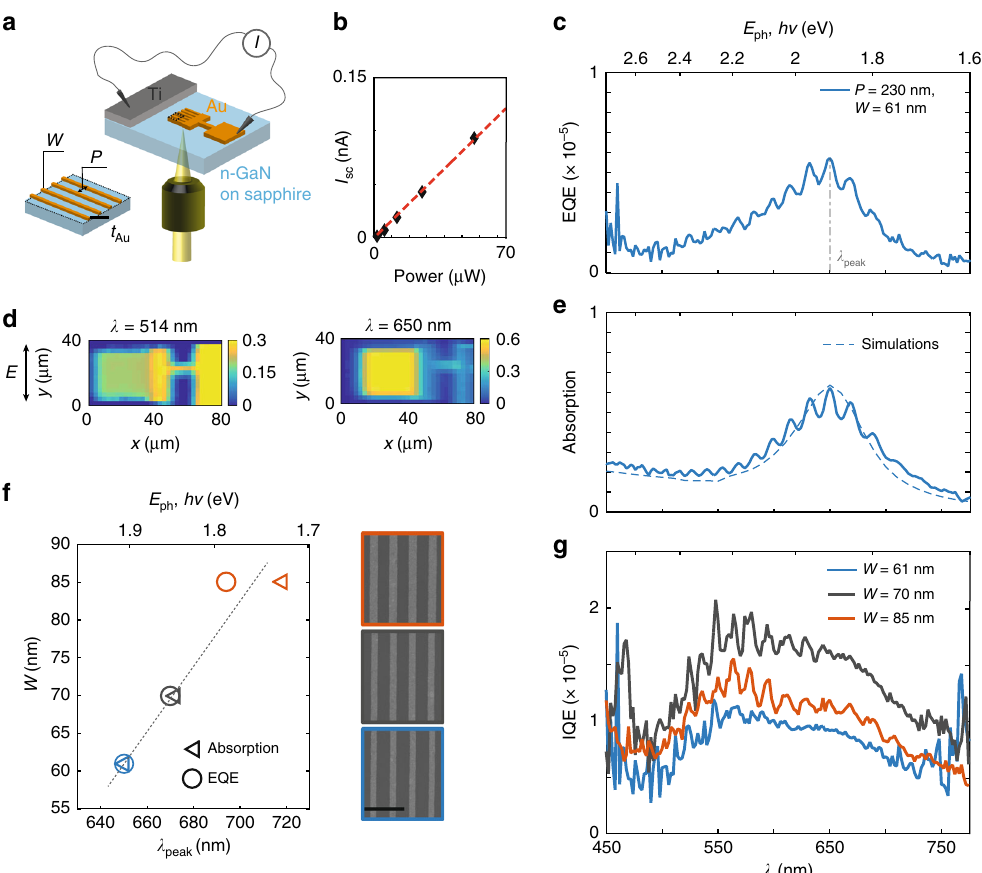
Fig. 2 Role of plasmon excitation on hot electron IPE in metal – semiconductor heterostructures. a Schematic representation of the designed plasmonic heterostructures as well as measurement con fi guration: a 20 nm thick, nano-patterned gold (Au) photoelectrode is fabricated on n-type GaN (3.4 eV band gap, Schottky barrier Φ B ~1.2 eV) together with a 75 nm thick titanium (Ti) Ohmic contact; light is incident on the plasmonic resonant Au nanostripe array (stripe width W , array period P from the bottom and the photocurrent is collected via two microcontact probes); b short-circuit photocurrent I sc (i.e., 0 V applied bias) upon illumination of one heterostructure ( W = 61 nm) with a diode laser ( λ laser = 633 nm) as a function of incident power; c EQE spectrum of the fabricated heterostructure with stripe width W = 61 nm and periodicity P = 230 nm exhibiting a resonance peak at λ peak = 650 nm; d spatial maps of absorption for illumination of the Au photoelectrode off-resonance (514 nm – 2.14 eV) and on-resonance (650 nm – 1.9 eV) with light polarized perpendicular to the stripes; e measured (solid line) and simulated (dashed line) absorption spectra for the same heterostructure exhibiting a plasmon resonance at λ peak = 650 nm; f EQE and absorption resonance peak wavelengths ( λ P = 230 nm) and peak ) for three heterostructures with constant array periodicity ( increasing nanostripe width, W , equal to 61 nm (blue), 70 nm (gray), and 85 nm (red), respectively. Representative SEM micrographs are shown on the right (scale bar = 500 nm); g IQE spectra of the three plasmonic heterostructures shown in part ( f rate is dependent on both incident photon energy and the elec- tronic band structure of the metal 32,35 . For photon energies below the interband threshold of Au ( h ν IB ~1.8 eV), hot electrons gen- erated via intraband transitions have a nearly uniform probability at all energies from the Fermi level up to the photon energy (Fig. 3a, solid red curve). As a result, intraband excitation accounts for a sizable fraction of the hot electron distribution at energies above the Schottky barrier height (gray shaded area in Fig. 3a). In this low photon energy regime there is very good agreement between the Fowler model, based on the parabolic band approximation, and full DFT calculations (compare solid red curve with dashed red curve in Fig. 3a). On the other hand, above h ν IB (Fig. 3b, solid turquoise curve), a much higher prob- ability distribution is observed for low-energy carriers, since hot electrons originate from d-band levels deep below the Au Fermi level 41 . Consequently, there is a substantial reduction in the fraction of high-energy electrons created from intraband transi- tions compared to that predicted for the case of a purely parabolic band (Fig. 3b, dashed turquoise curve). This interplay, combined